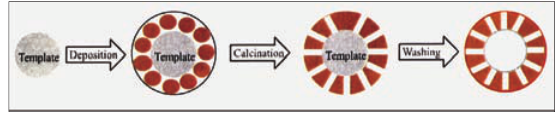
Fig. 7 Illustration on preparation of hollow porous SiO 2 particles prepared by CaCO 3 template method 91)